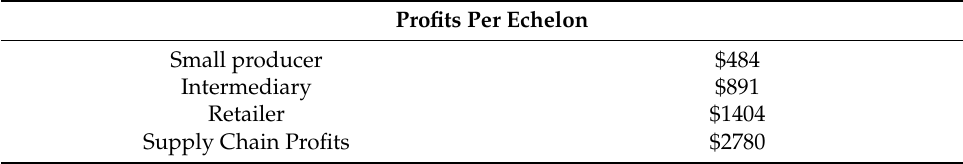
Table 1. Chain profit results without backup agreement.